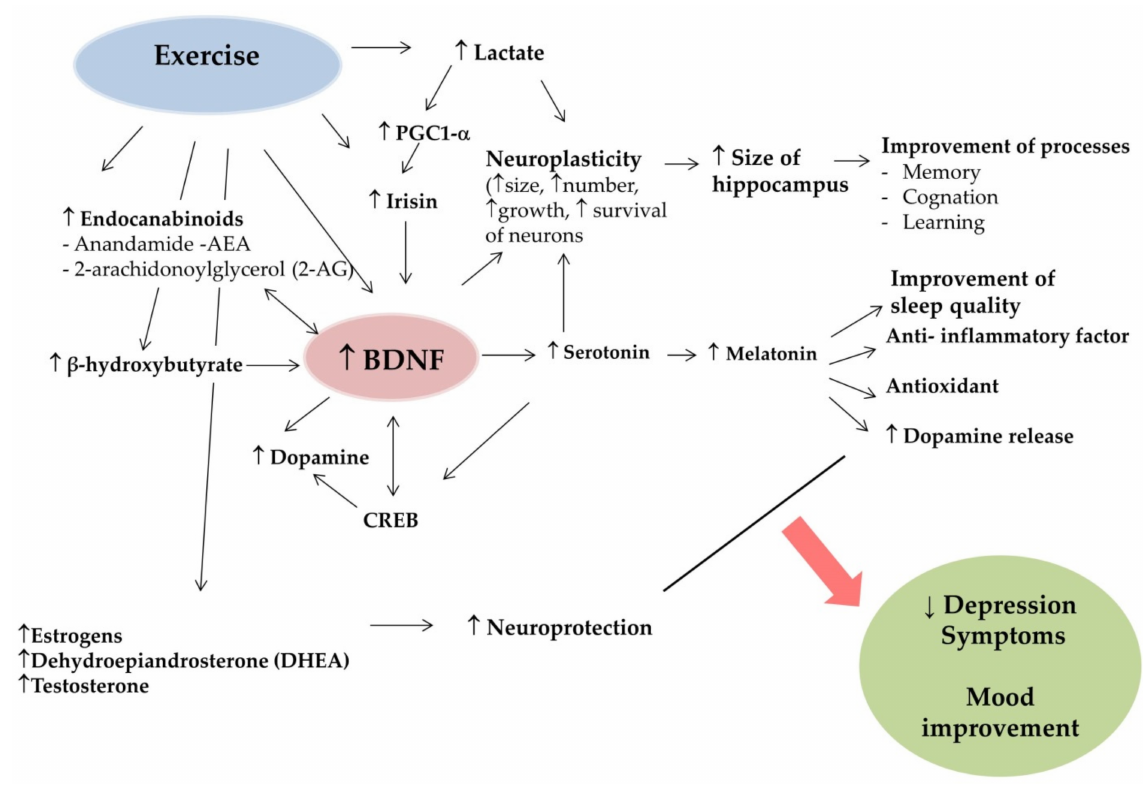
Figure 1. Potential mechanisms of ET impact on BDNF to decrease depression symptoms. (PGC1- α , peroxisome proliferator-activated receptor-gamma coactivator; BDNF, brain-derived neurotrophic factor; CREB, cAMP-response element binding